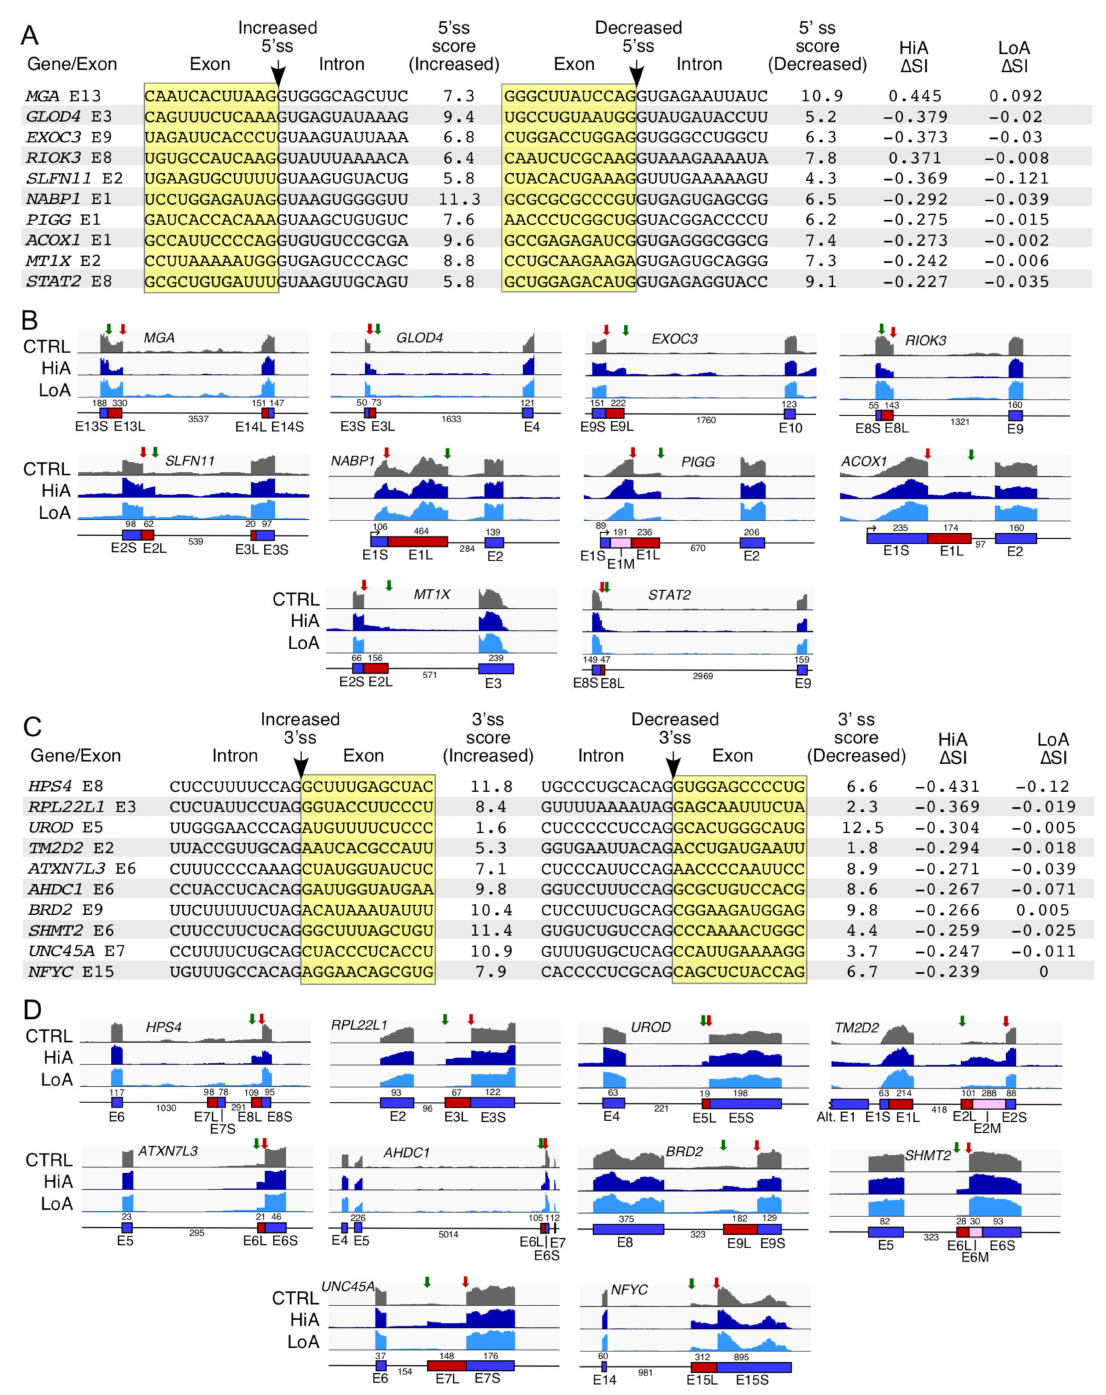
Figure 7. Alternative 5 (cid:48) ss and 3 (cid:48) ss usage caused by Anti-N1 treatment. ( A ). The sequence context of two alternative 5 (cid:48) ss of 10 candidate exons whose usage either increased or decreased upon Anti-N1 treatment. At the right of each sequence, the predicted strength of each 5 (cid:48) ss is shown. ∆ SI indicates the change in proportional usage of the shorter isoform upon Anti-N1 treatment. Other coloring and labeling are the same as in Figure 3A. ( B ). Genomic views of the alternative 5 (cid:48) ss shown in panel A. Red arrows indicate the 5 (cid:48) ss with decreased usage, green arrows, the 5 (cid:48) ss with increased usage. Other labeling and coloring are the same as in Figures 3C and 6B. ( C ). The sequence context of two alternative 3 (cid:48) ss of 10 candidate exons whose usage either increased or decreased upon Anti-N1 treatment. Other table contents and annotation are the same as in Figure 3A. ( D ). Genomic views of the alternative 3 (cid:48) ss shown in panel C. Red arrows indicate the 3 (cid:48) ss with decreased usage, and green arrows the 3 (cid:48) ss with increased usage. Other coloring and labeling are the same as in Figures 3C and